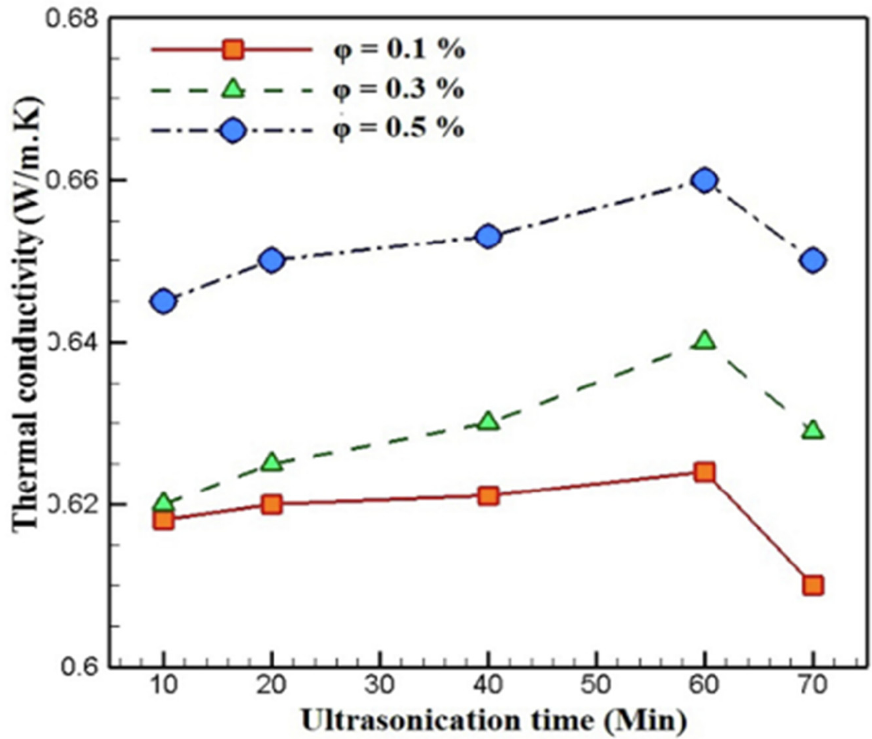
Figure 4. Thermal conductivity of MWCNT/water NF against ultrasonication time at the temperature of 35 °C and different concentrations. Adapted from [148].